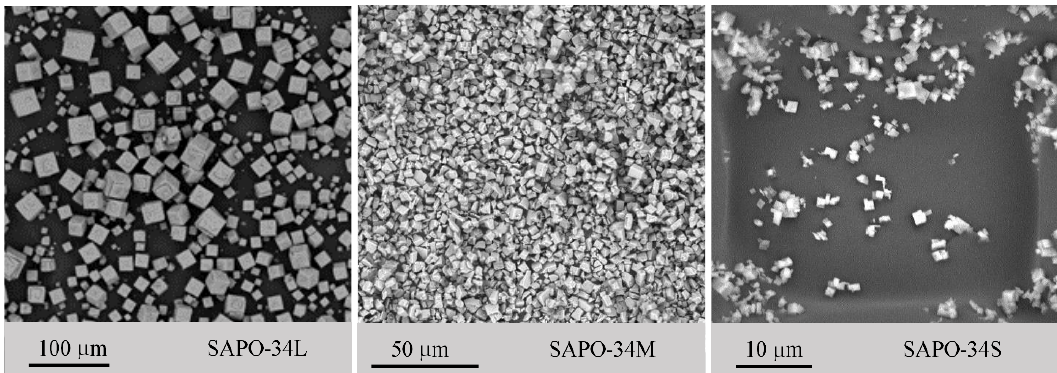
Figure 2. SEM images of the synthesized zeolites: SAPO-34L, SAPO-34M and SAPO-34S (from left).